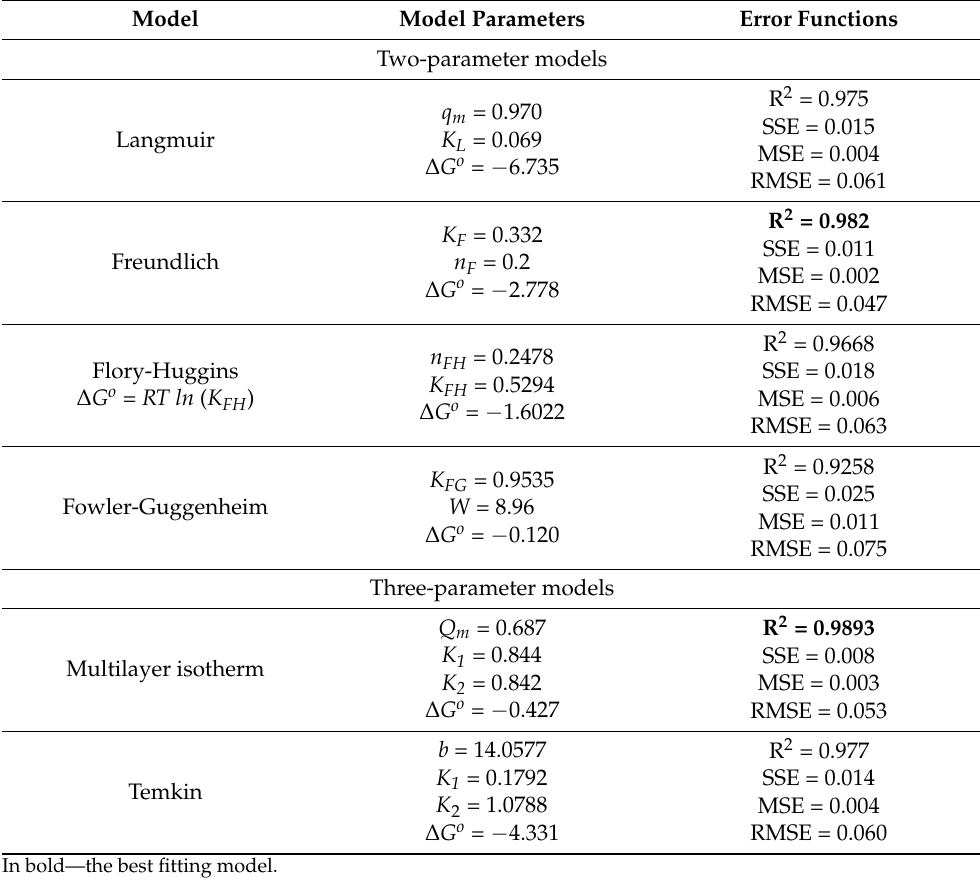
Table 1. Encapsulation mathematical models—model parameters and error function values.